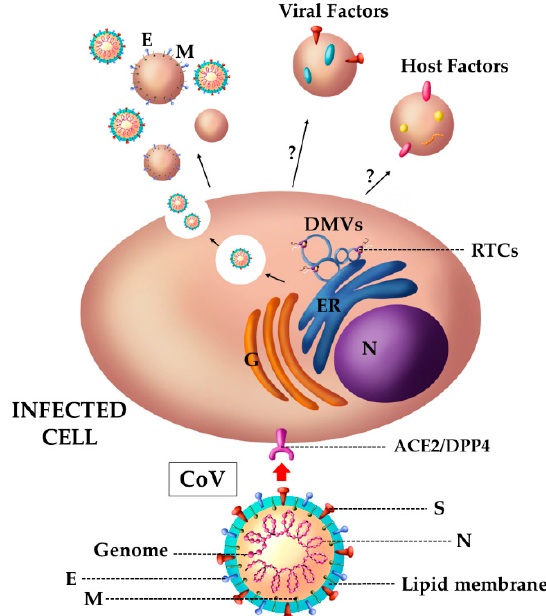
Figure 4. Schematic representation of EVs released by coronavirus (CoV)-infected cells. CoVs hijack the cellular machinery to favor their replication. CoVs proteins promote the formation into the cytosol of double-membrane vesicles (DMVs) that are associated to the replication and transcription complexes (RTCs) where the viral replication occurs. After the production of structural and non-structural proteins, the budding can take place from Golgi and ER membranes. Subsequently, viral particles are released into the extracellular space by exploiting the vesicular network. In addition to viral particles, CoVs induce the release of vesicles carrying the viral envelope (E) and membrane (M) proteins. To date, there are not clear evidences of vesicles released by CoV-infected cells transporting other viral or host factors. Nucleus (N); endoplasmic reticulum (ER); Golgi complex (G).